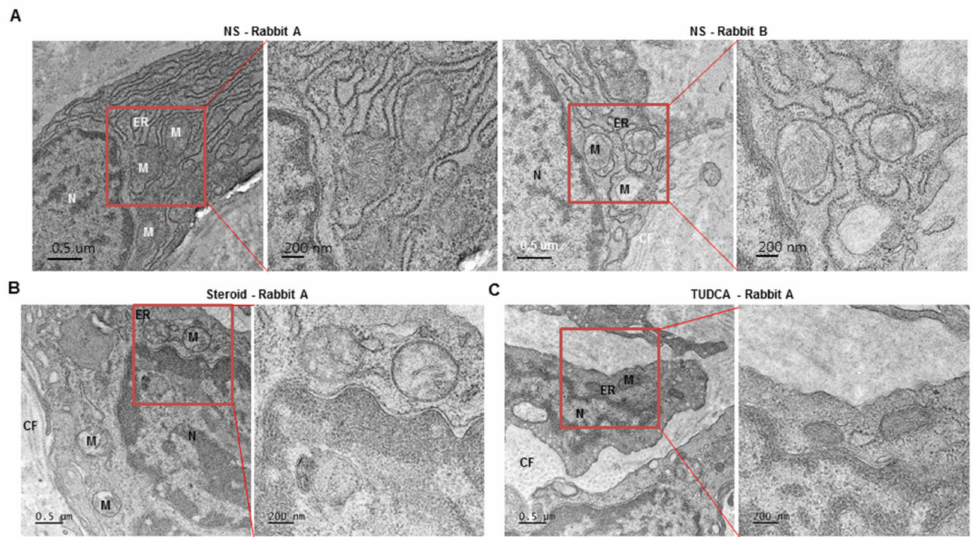
Figure 5. Representative images of transmission electron micrographs of rabbit ear scar models (NS group = 4 rabbits, steroid group = 3 rabbits, TUDCA group = 3 rabbits). ( A ) normal saline, ( B ) steroid (10 mg/mL), and ( C ) TUDCA (10 mg/mL).